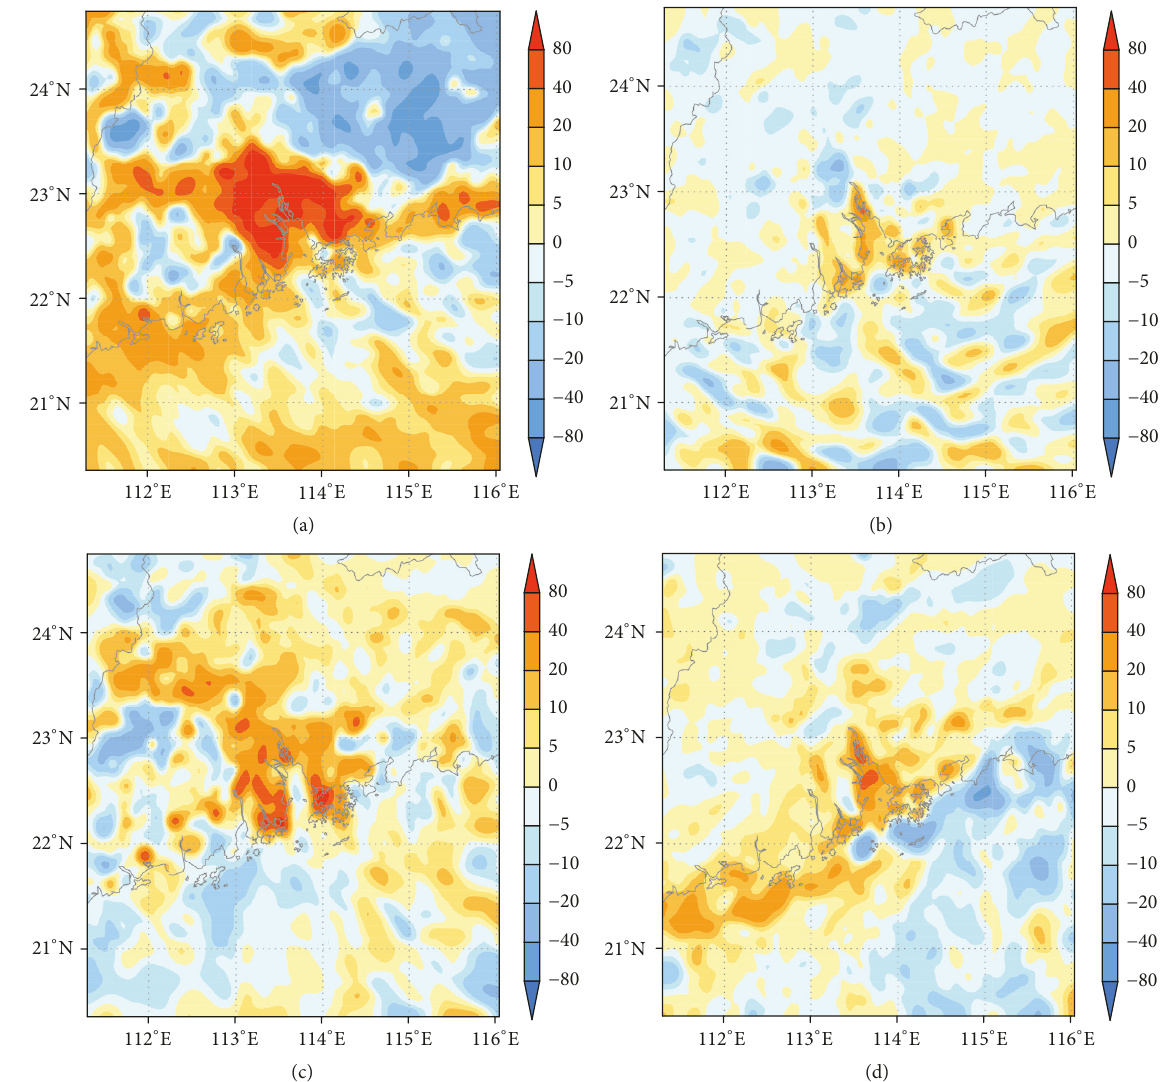
Figure 6: As in Figure 3, but for ground upward 1-h accumulated sensible heat fluxes (unit: Wm −2 ).